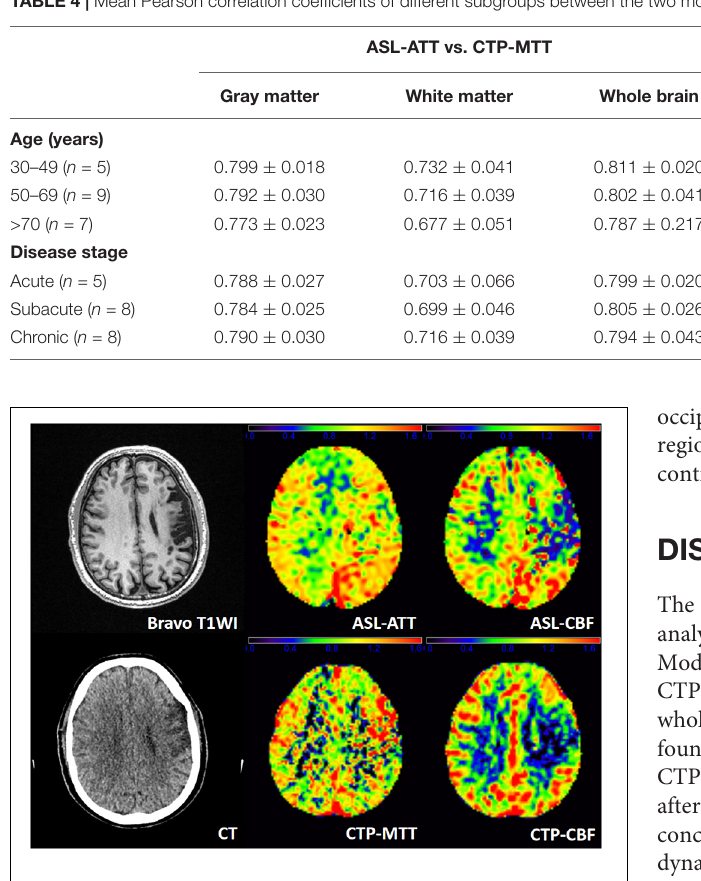
FIGURE 3 | A patient admitted to the hospital with weakness in the right upper limb for 1 day, and he had a history of ischemic stroke last year. T1WI demonstrates an obsolete infarct in the left frontal lobe. ASL-ATT, CTP-MTT, ASL-CBF, and CTP-CBF are normalized images and present consistent results. CTP shows hypoperfused regions in the left frontal lobe. CTP-CBF of the left frontal lobe is lower than the contralateral side, and ASL shows decreased ASL-CBF of the left frontal lobe. CTP-MTT is higher in the infarcted area but not in the surrounding regions, whereas the ASL-ATT is decreased (probably no signal) in the infarcted region and increased in the surrounding regions/territories (fitting with the atrophy